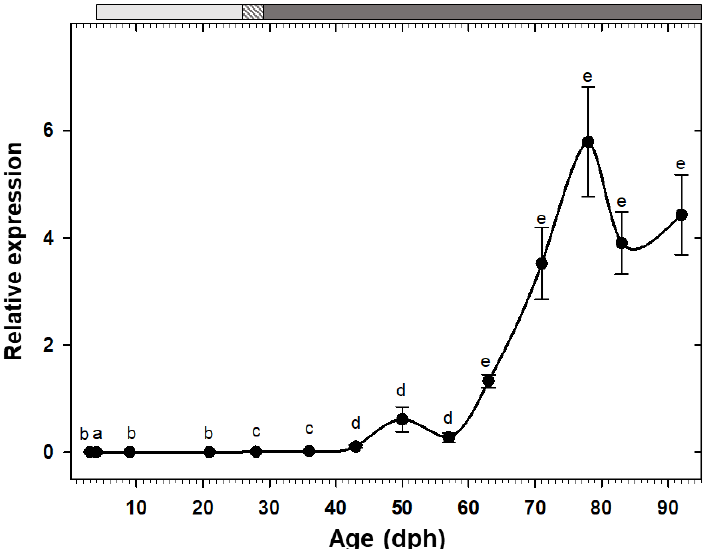
Figure 4. Transcriptional changes of amy2a in whole-body C. labrosus individuals during development (N = 6 to 10 individuals per sampling point). The rest of legend as in Figure 2.